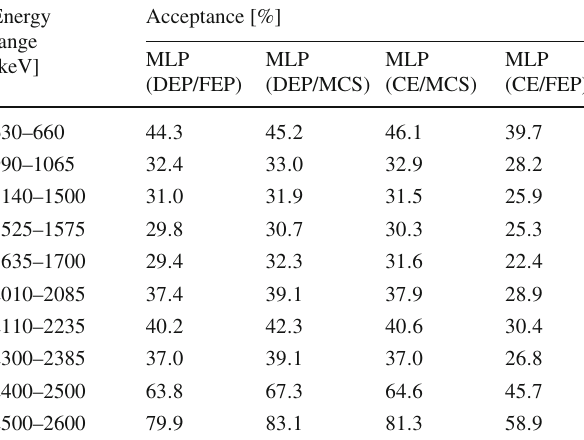
Table 2 Reduction of background continuum in the selected energy ranges ( 228 Th spectrum) after applying MSE PSA cut (DEP events acceptance set to 5% for all training